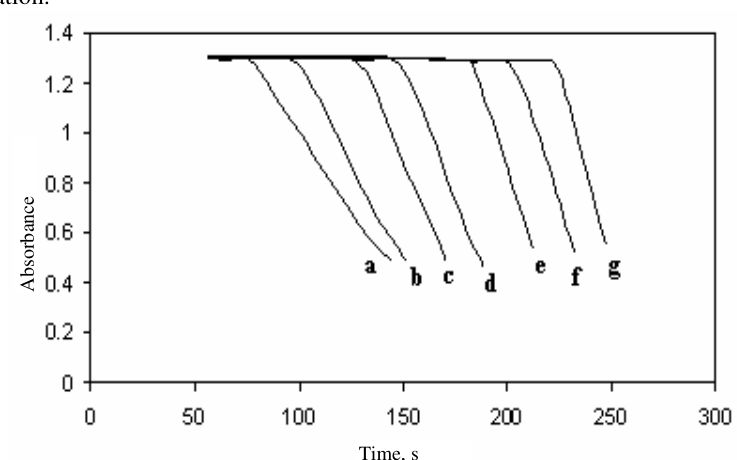
Figure 1 . Change in absorbance of 10 mg L -1 methyl orange solution over time in the presence of 6.5 × 10 -4 mol L -1 bromate, 0.35 mol L -1 HCl and (a) 3.3 × 10 -5 ; (b) 4.9 × 10 -5 ; (c) 6.6 × 10 -5 ; (d) 8.2 × 10 -5 ; (e) 9.9 × 10 -5 ; (f) 1.1 × 10 -4 ; (g) 1.3 × 10 -4 mol L -1